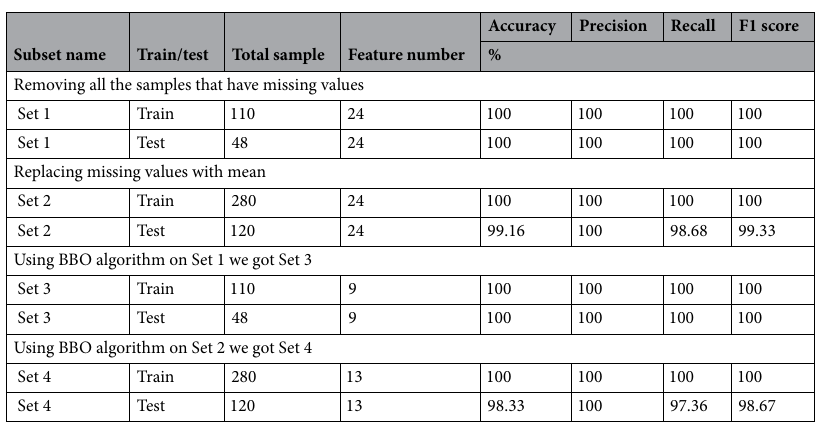
Table 4. Classification results on the CKD subsets.